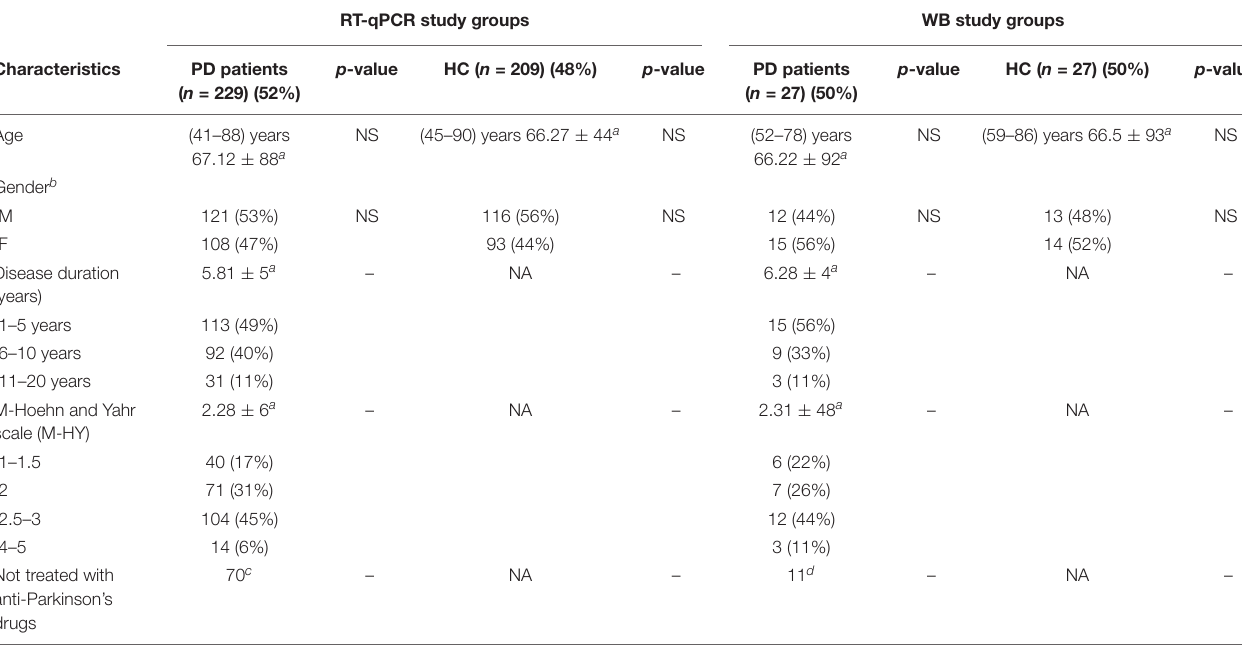
TABLE 1 | Demographics and clinical characteristics of PD patients and